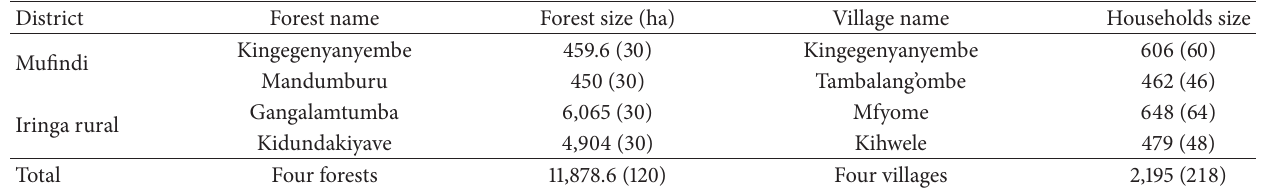
Table 2: Study district and village, sample size, and forest name used in data collection. District Forest